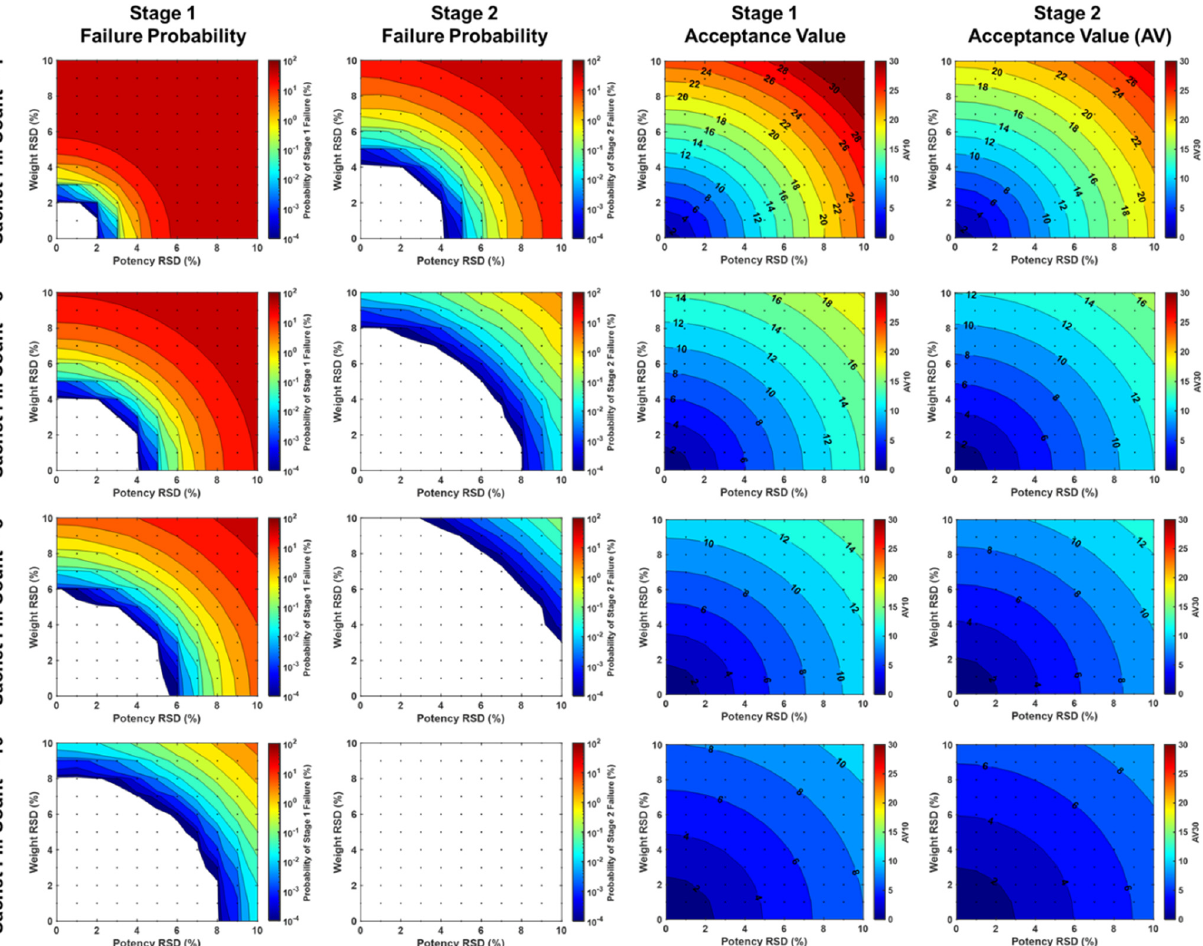
Figure 4. Probability of stage 1 and stage 2 content uniformity batch failure and acceptance values for 0% fill error probability represented as a function of modeled bulk mini-tablet weight RSD (vertical axes), bulk mini-tablet potency RSD (horizontal axes), and sachet fill count (rows). Tabulated values may be found in Supplementary Materials Section